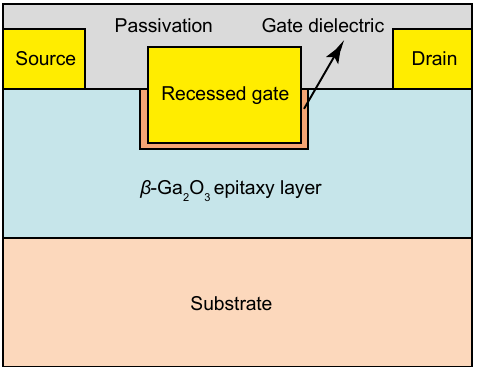
Figure 13. Device structure of the β ‐ Ga 2 O 3 FET with a recessed ‐ gate structure.